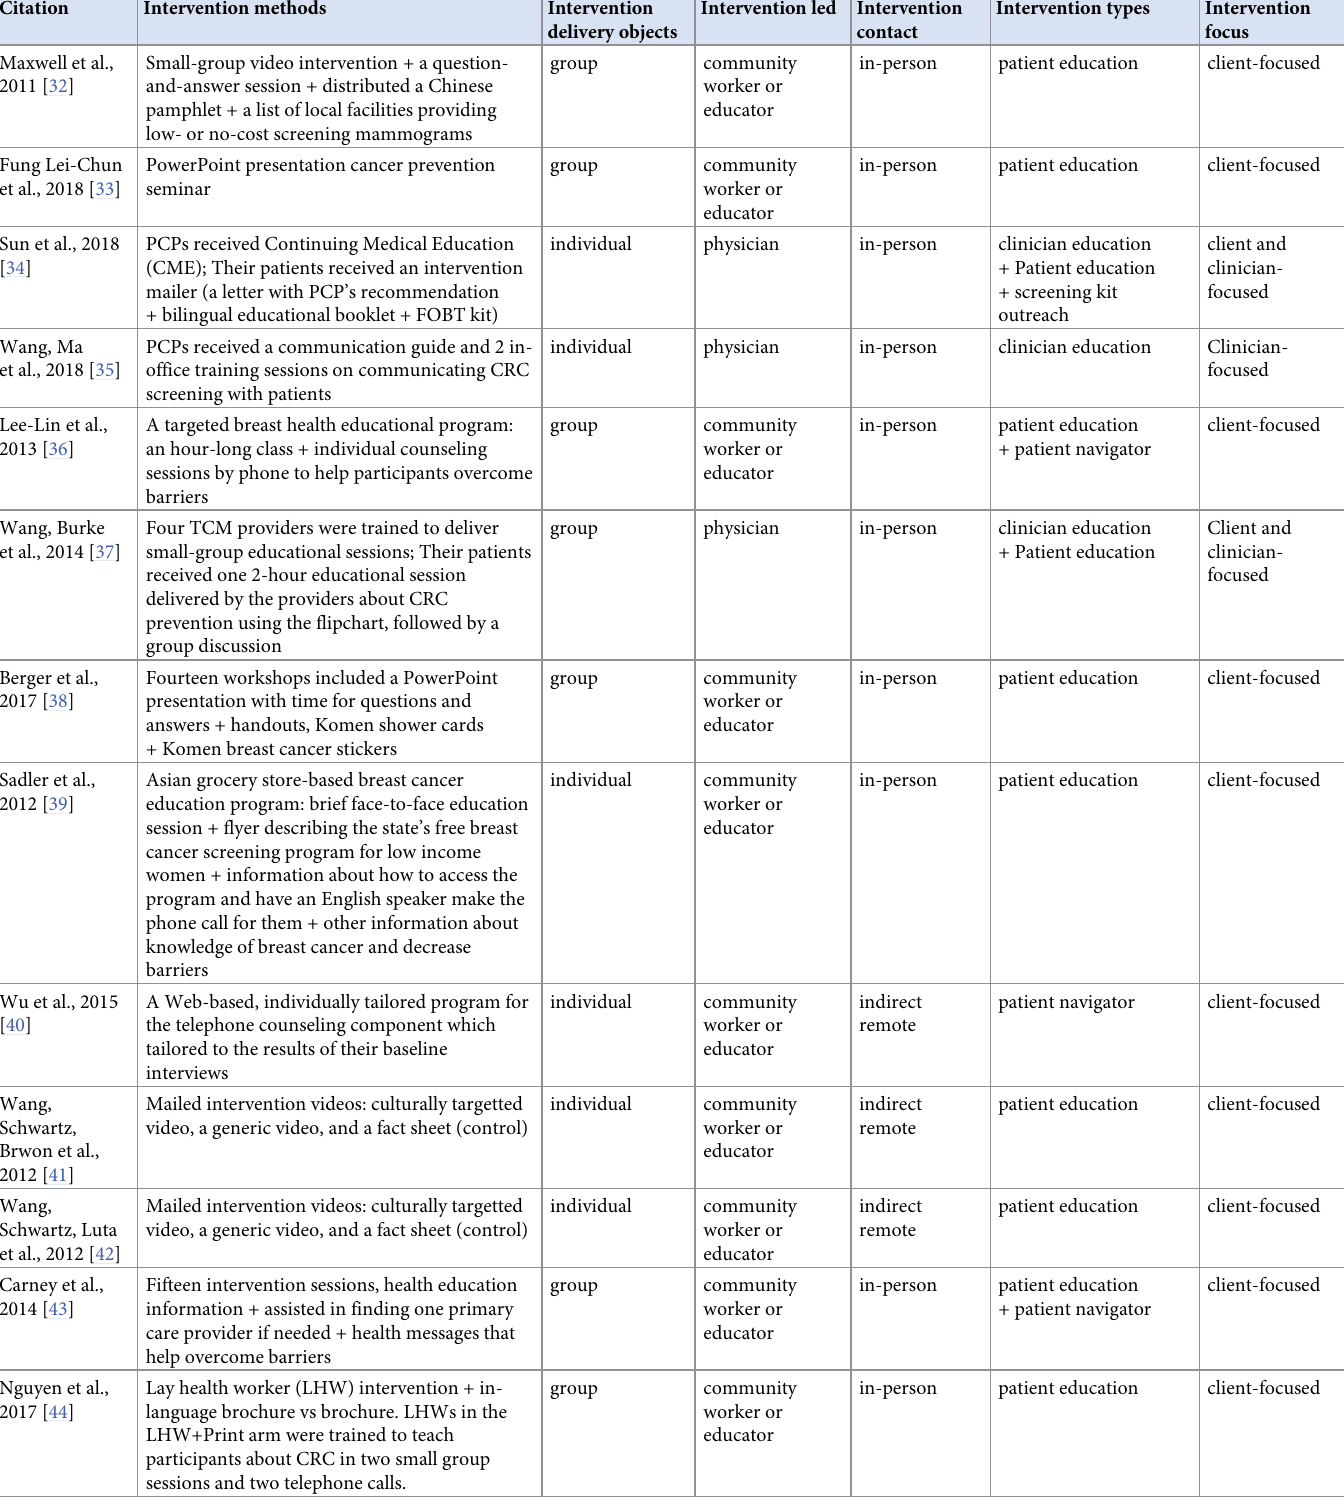
Table 3. Intervention characteristics of the included